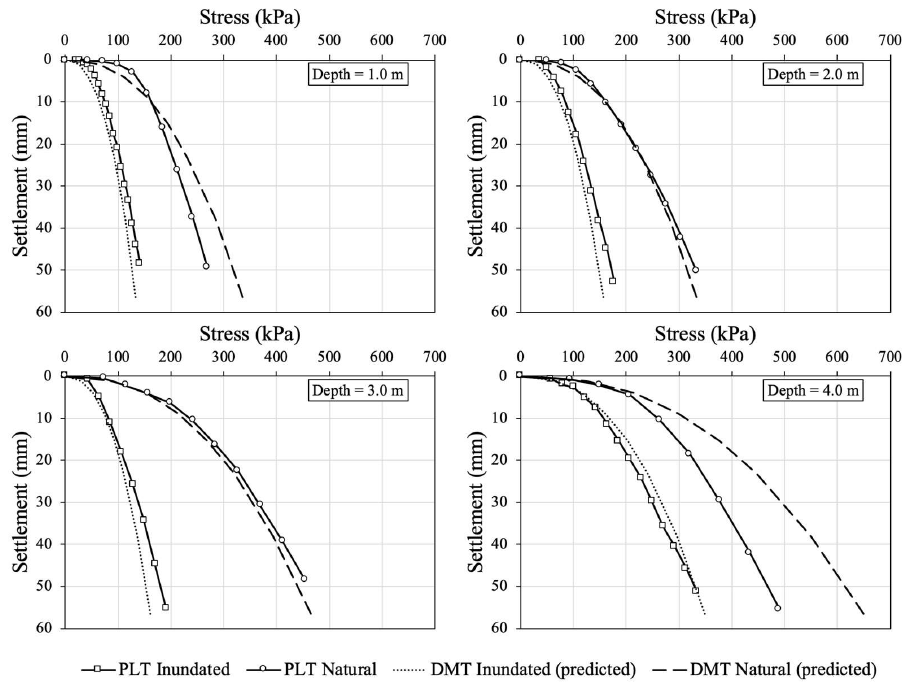
Figure 11. Load–settlement curves measured by PLT and predicted by DMT results, under natural and inundated conditions, for 1.0, 2.0, 3.0, and 4.0 m depth.